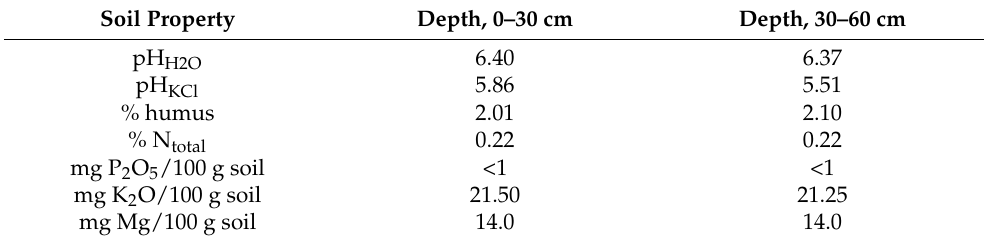
Table 1. Chemical soil properties of selected